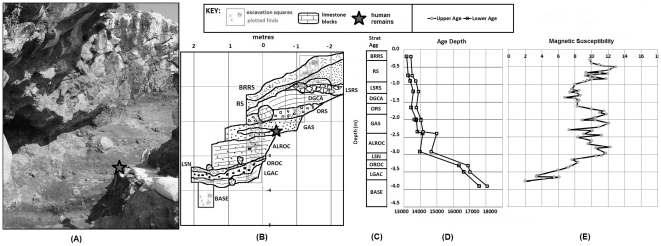
Maludong site.(A) stratigraphic sequence; (B) GIS plotted stratigraphy based on total station data and indicating excavation units and plotted finds; (C) stratigraphic aggregates; (D) Upper and Lower age limit of calibrated radiocarbon ages; and (E) magnetic susceptibility record (×10−6 m3 kg−1).